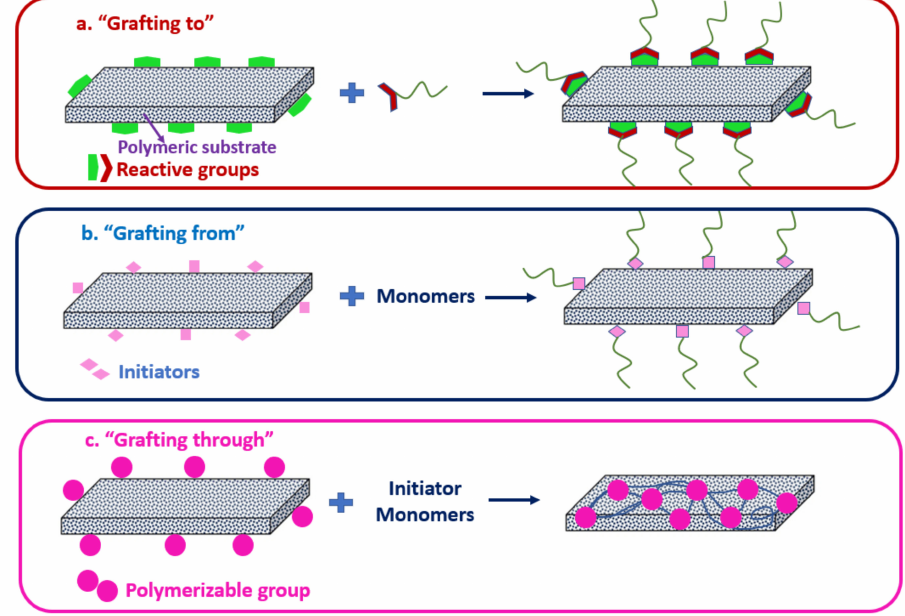
Figure 1. Strategies of polymer grafting: ( a ) grafting-to; ( b ) grafting-from; ( c )